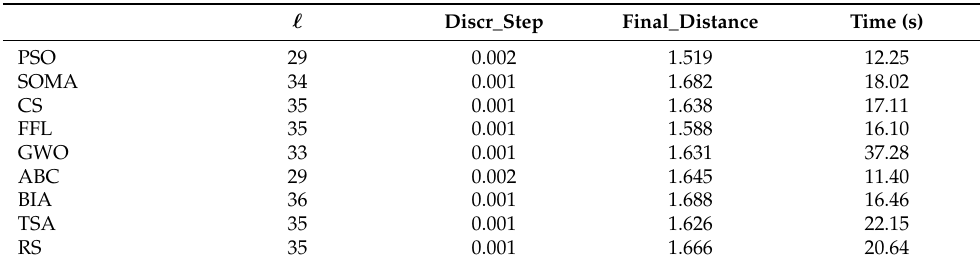
Table 12. The mean results for Function f 4 for 50 runs of evolutionary algorithms with a value of maxFES = 2500.